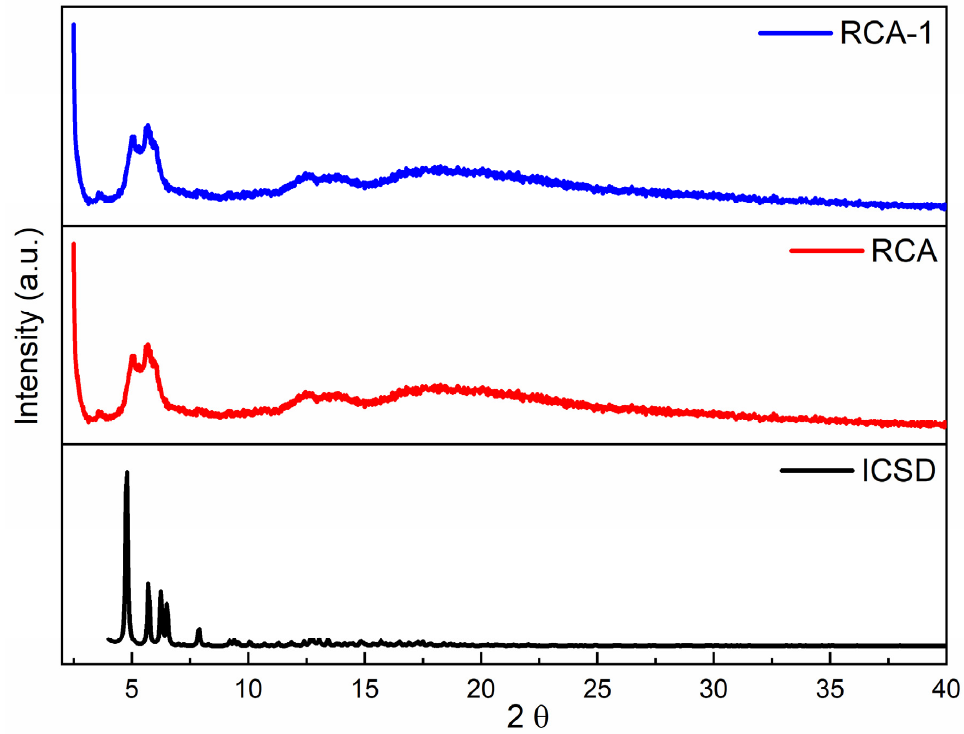
Figure 2. X-ray powder diffraction profiles for bioMOF-100: simulated by ICSD (file number: 833315), solid obtained as synthesized (RCA) and activated (RCA-1).